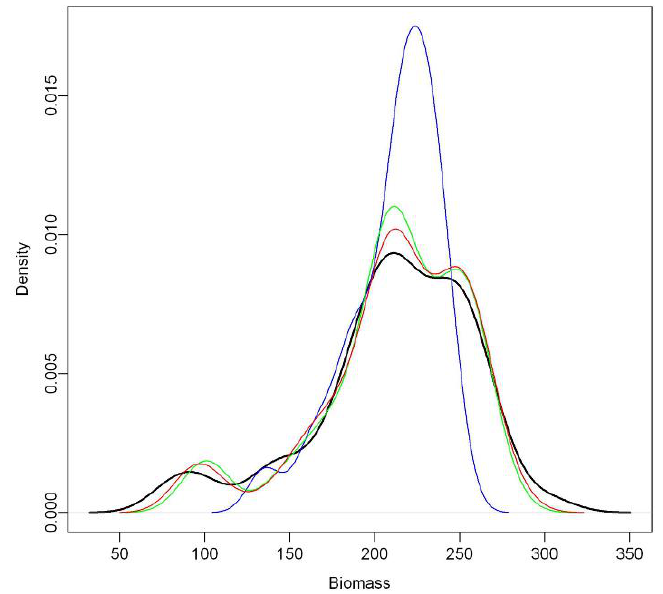
Figure 4. Density functions of observed (black line) and predicted values of biomass for different models: INVE (red line), TMTO (blue line), and ALL (green line) models.